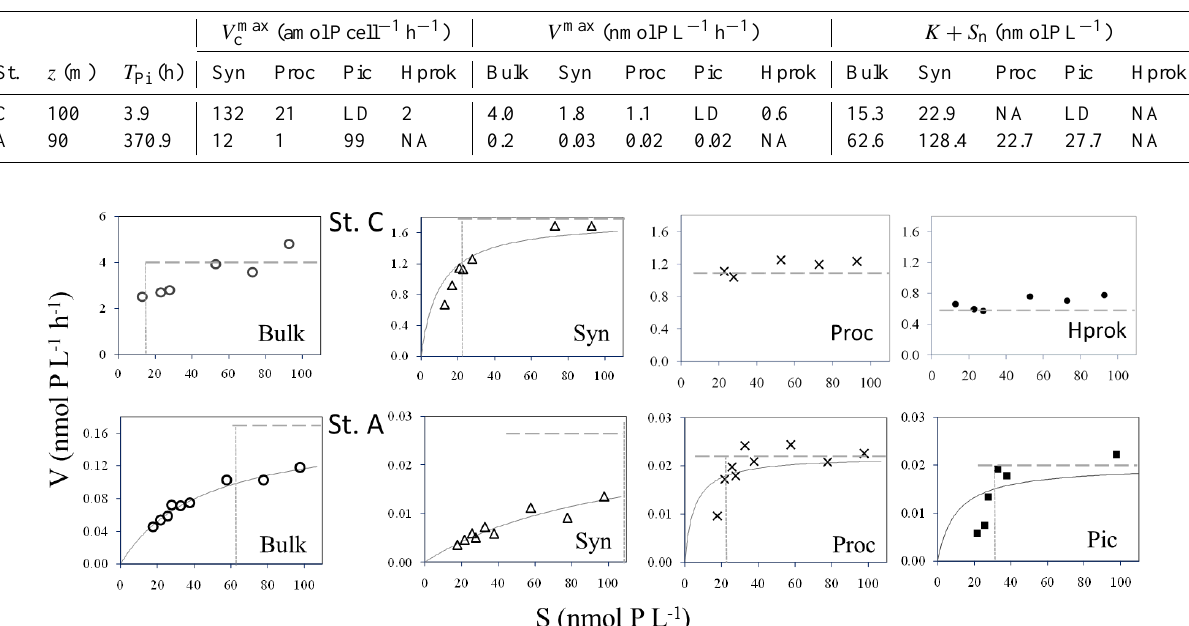
Table 2. Pi uptake kinetic characteristics of the bulk community and sorted groups: V max is the theoretical volumetric maximum uptake rate of a group, V max c